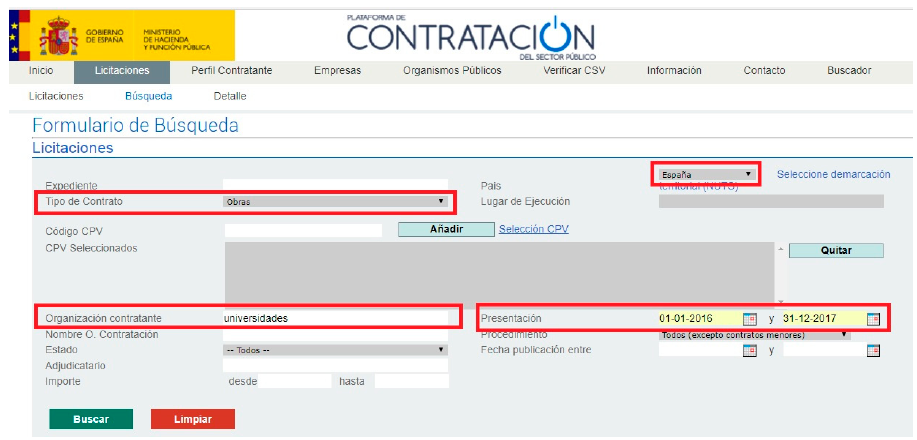
Figure 2. Spanish public sector procurement platform [64].